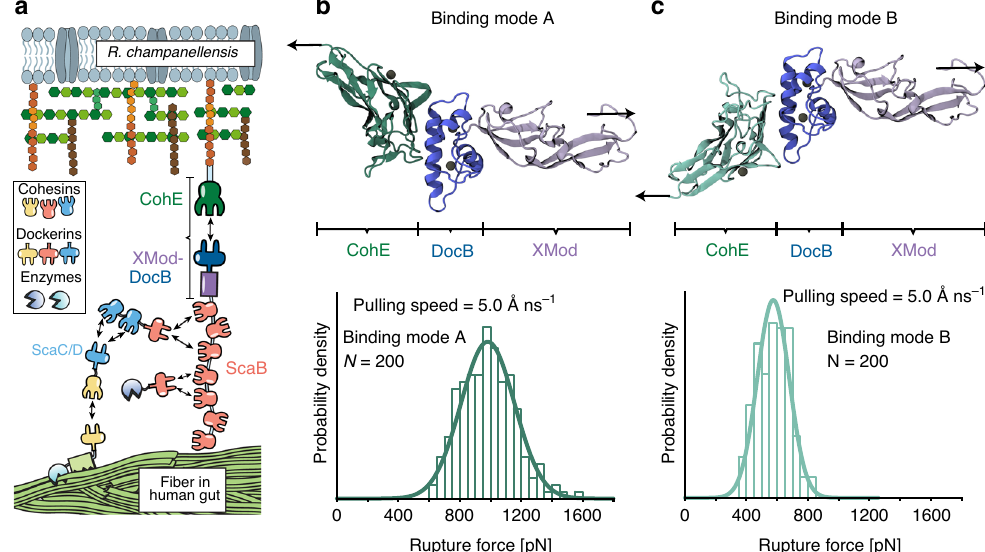
Fig. 1 Rc XMod-Doc:Coh complex, dual-binding modes, and molecular dynamics simulation of complex dissociation. a The Rc -cellulosomal network is assembled through interactions between Doc and Coh domains. Cellulose-binding domains, digestive enzymes, and structural scaffold proteins (Sca) self- assemble into a cellulosome complex, which binds and digests cellulose fi bers in the human gut. XMod-DocB and CohE form a mechanically stable protein complex that anchors the cellulosomal network to the cell surface. b , c Structural models showing the XMod-Doc:Coh complex in the two hypothesized- binding modes. Green: Coh, blue: Doc, purple: XMod. Calcium ions are shown as black spheres. In both binding modes, the rupture forces observed for the fi ve most stable models were measured by performing 200 steered molecular dynamics (SMD) replicas and plotting as histograms. The pulling directions are marked by black arrows. Rupture force histograms were fi tted with Gaussian distributions. The most probable rupture force was 981 pN in binding mode A (panel b ) and 575 pN in binding mode B (panel c ) at a pulling speed of 5.0 Å ns − 1